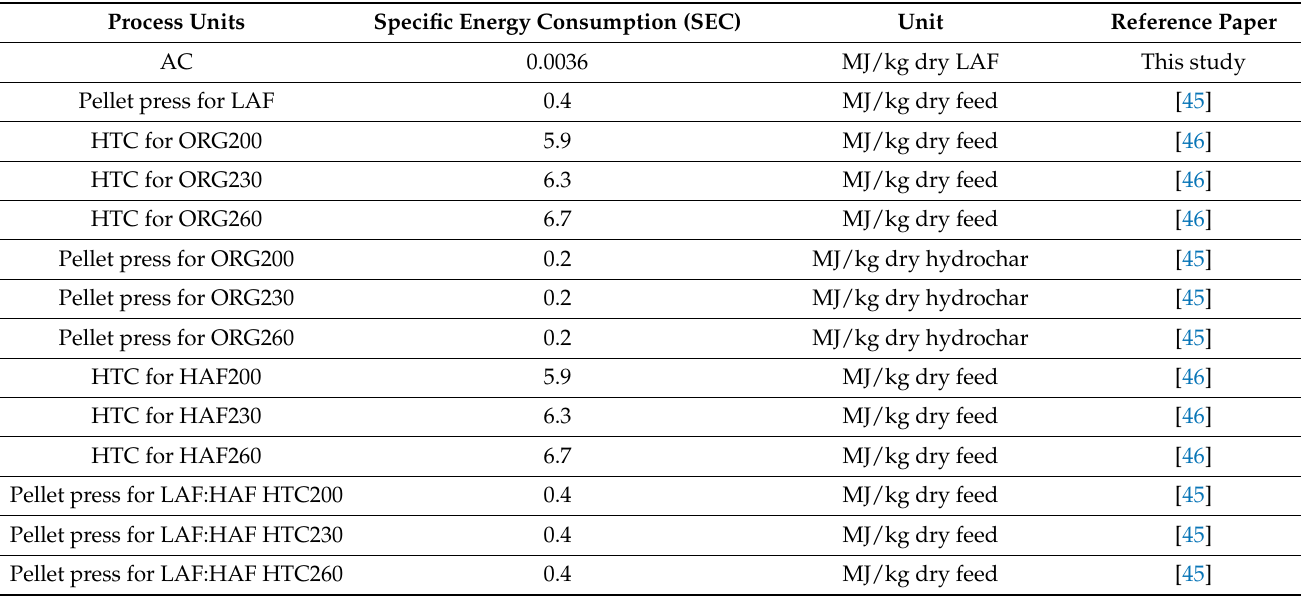
Table 3. Specific energy consumption for each process unit.